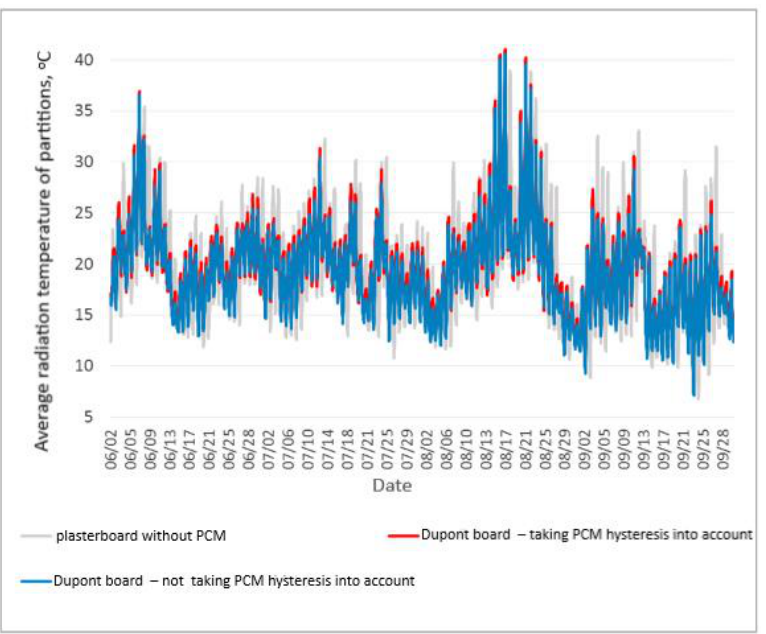
Figure 7. Average hourly values of radiation temperature of partitions in a building with Dupont boards.